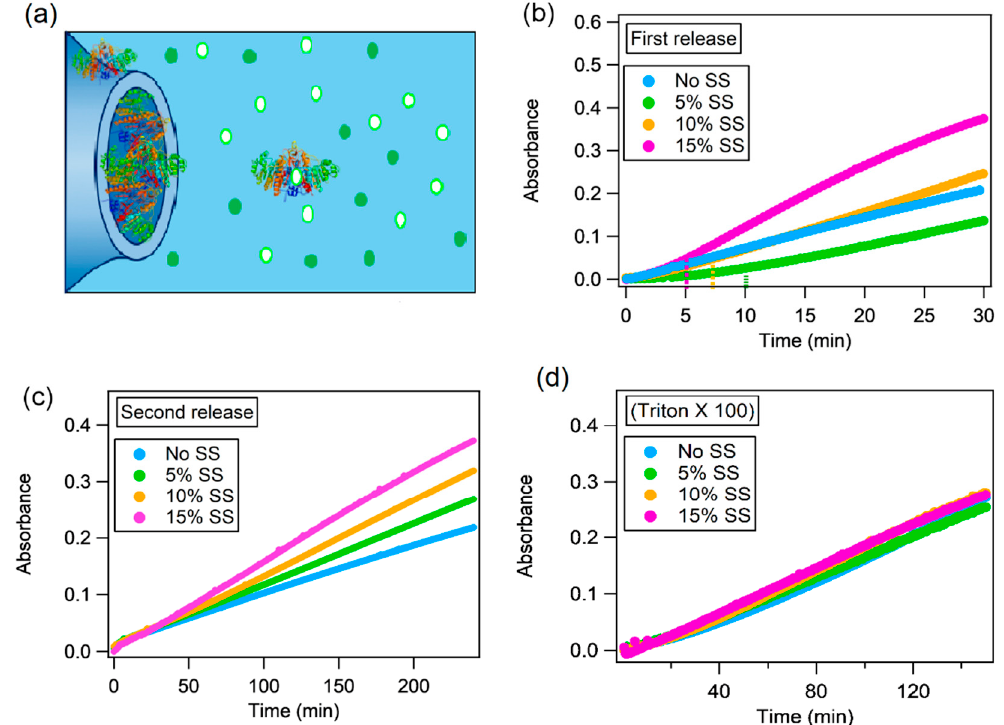
Figure 4. Reaction kinetics with the enzyme confined in liquid crystalline mesophases. ( a ) Sketch of the experiment of AP-catalysed reaction with the enzyme confined in the cubic mesophase; ( b–d ) UV–vis absorbance of p-nitrophenol in solution, recorder at 400 nm for the initial 30 min ( b ), for additional 250 min (upon buffer replacement with a fresh buffer and substrate solution, as described in the text) ( c ), and, finally, upon disruption of the mesophase with Triton-X-100 ( d ), as described in the text. The different curves are related to experiments performed with the enzyme confined in the different mesophases: No SS (cyan markers), 5% SS (green markers), 10% SS (orange markers) and 15% (purple markers).